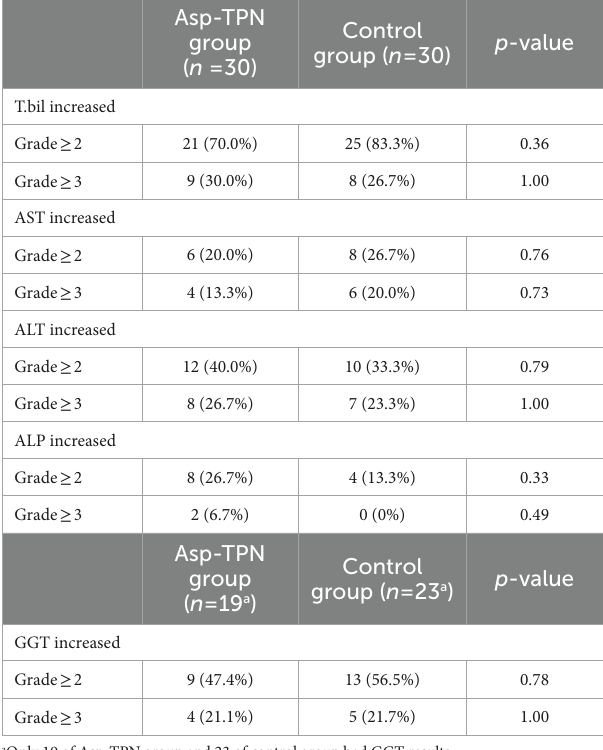
TABLE 4 The frequency of Grade 2 or more adverse events associated with LFT